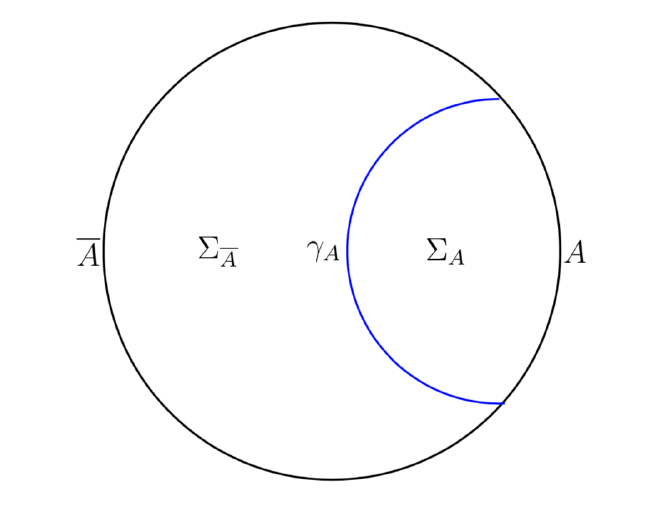
Figure 1: The t = 0 slice of the bulk and boundary. The boundary is separated into two regions A and ¯ A . The bulk is also separated into two regions Σ hangs from the boundary entangling